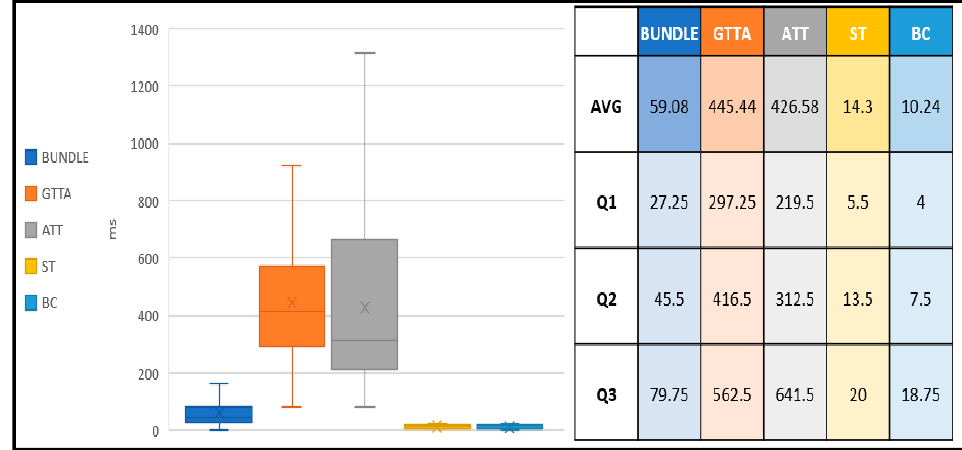
Figure 11. Breakdown of transaction release cost.